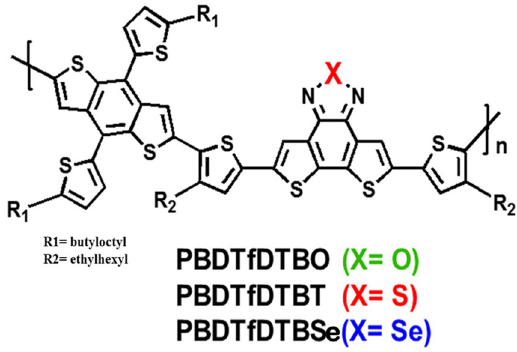
Figure 1. Chemical structure of polymer PBDTfDTBX (X = O, T(S), Se).